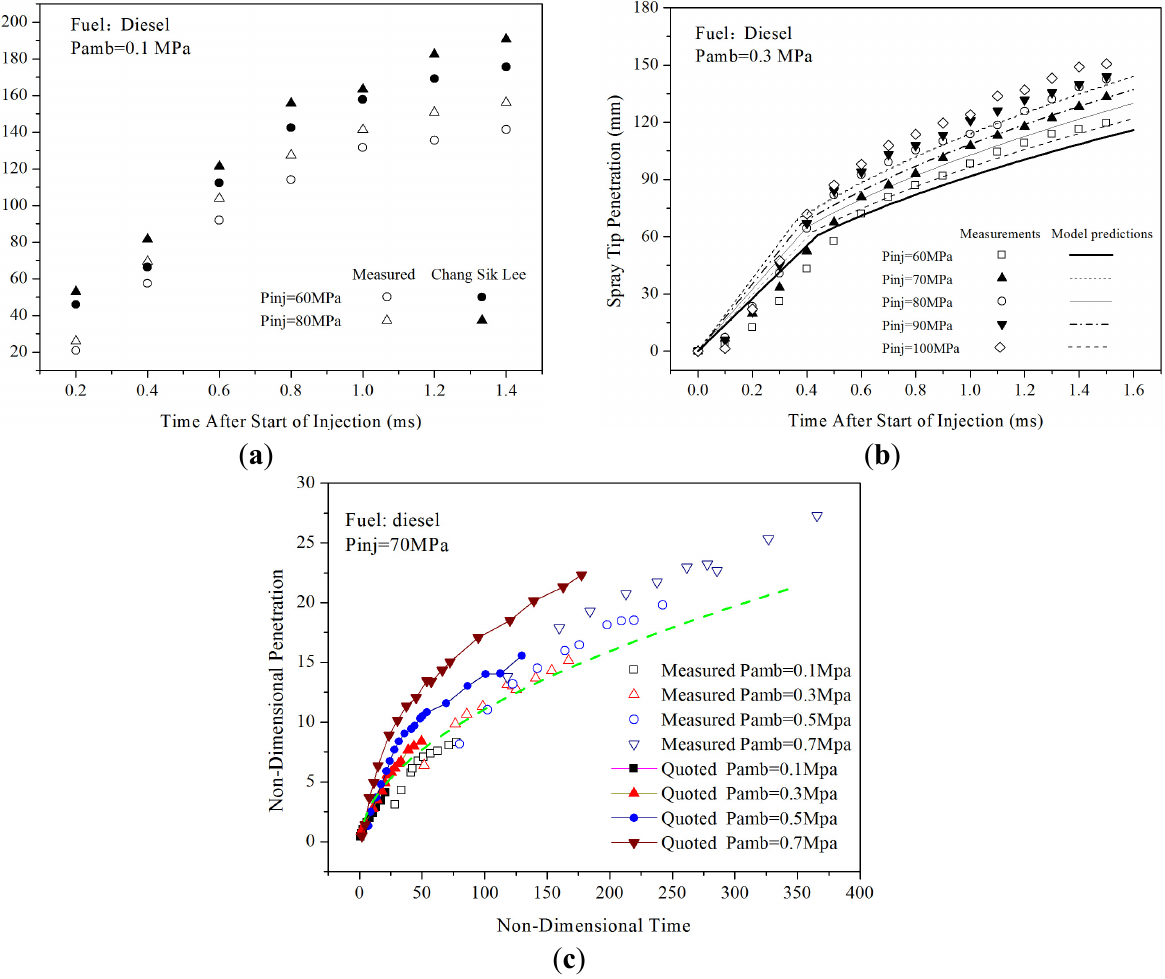
Figure 3. Comparison of spray tip penetration for experimental results and empirical equations. ( a ) Compared with the experimental result obtained by Lee and Park [25]; ( b ) compared with the empirical equation data of Hiroyasu and Arai [26]; ( c ) non-dimensional penetration versus non-dimensional time (the dashed line was obtained from Equation